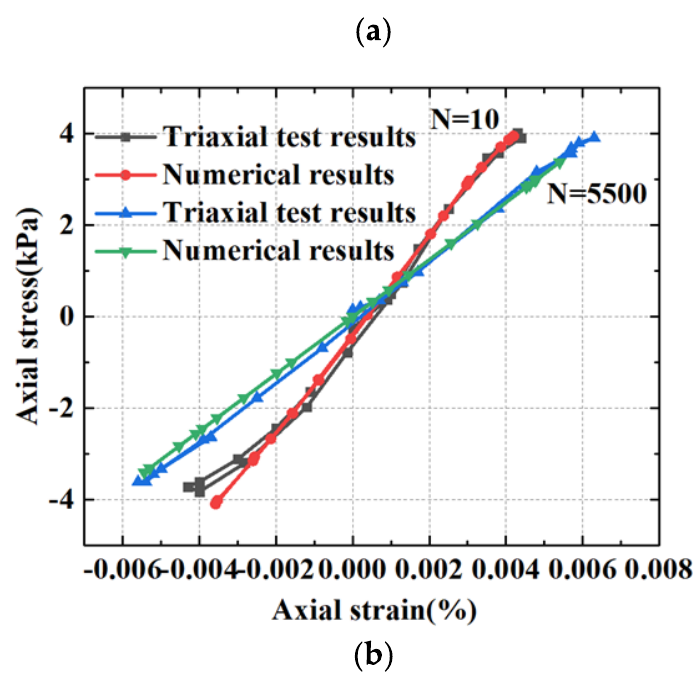
Figure 19. Comparison chart of numerical simulation results and test results. ( a ) Consolidated undrained triaxial-shear-test comparison chart; ( b ) Dynamic-cycle-test comparison chart.